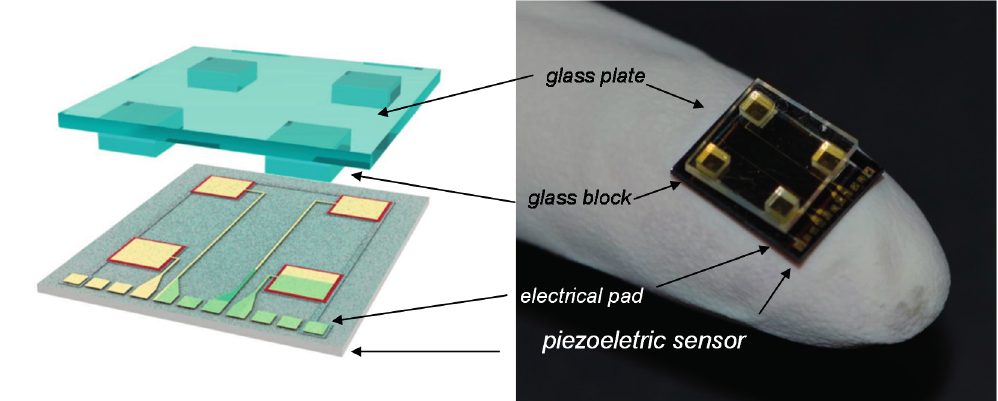
Figure 3. Integration of the four force balances. The glass plate was prepared with four legs in direct contact with the